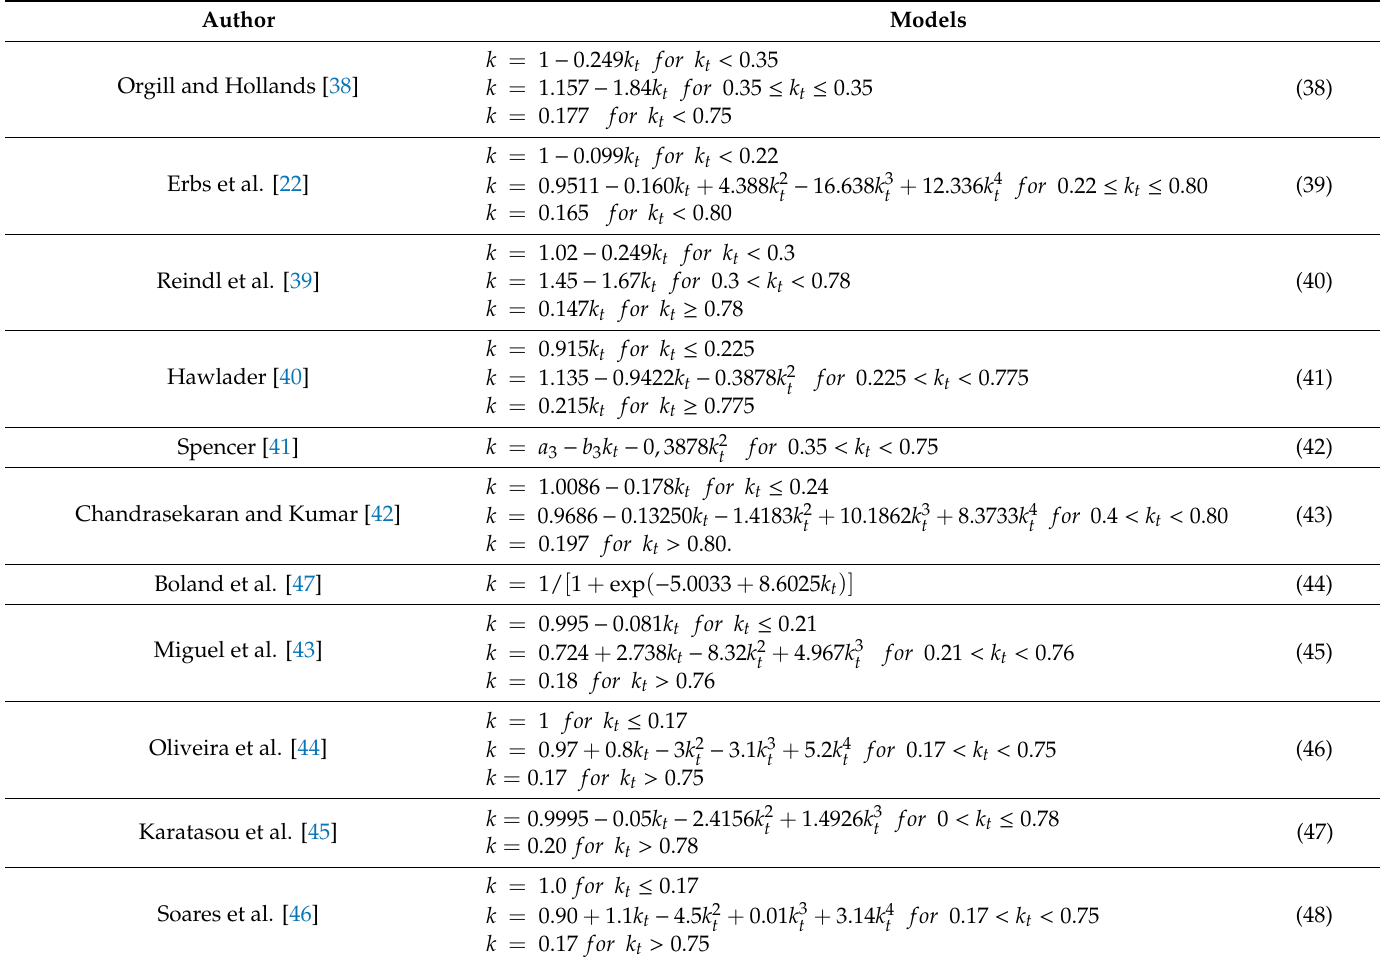
Table 3. Instantaneous Hourly Irradiation